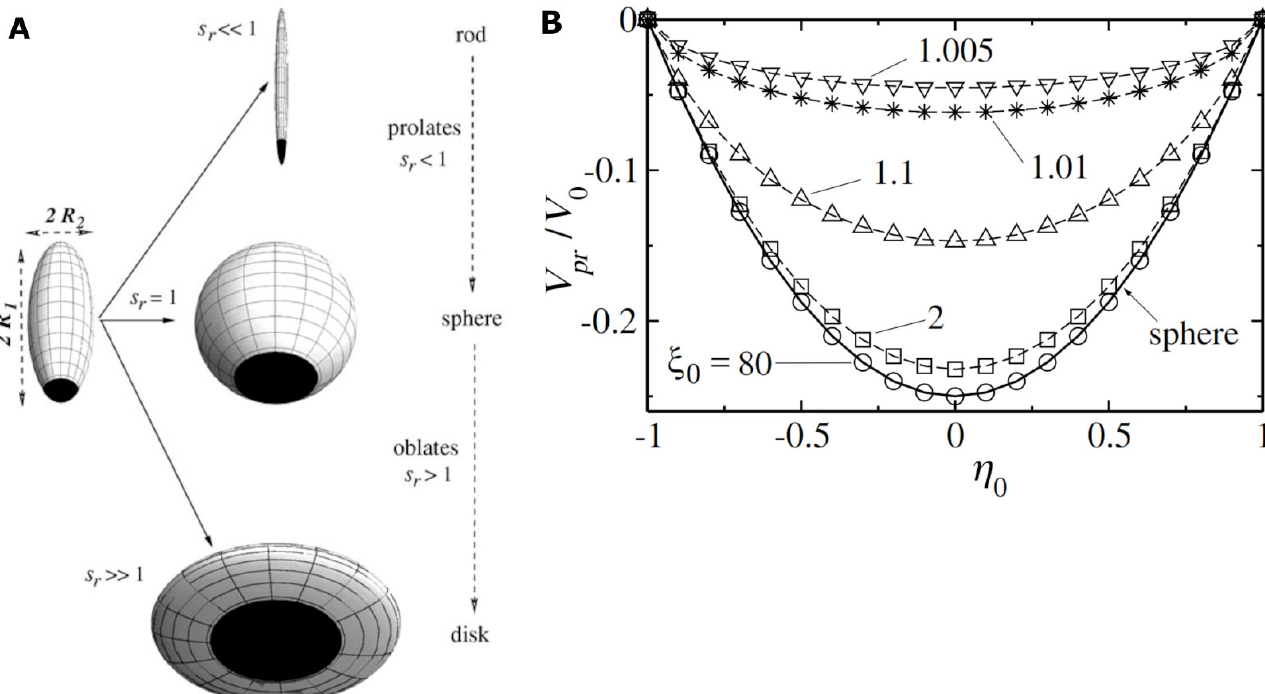
Figure 3. ( A ) Schematic representation of spheroidal catalytic micromotors characterized by the same polar semi-axis ( R 1 ), different equatorial semi-axes ( R 2 ), and, thus, different aspect ratios s r = R 2 / R 1 . (Obs.: The part of the catalytic micromotor covered by catalyst, that is, the active cap of the catalytic micromotor, is depicted as a black area). ( B ) The dependence of the scaled phoretic velocity ( V pr / V 0 ) on the fraction of the surface of the catalytic micromotor covered by the catalyst ( η 0 = − 1, 0, 1, respectively, correspond to a micromotor surface with no catalyst, with the lower half covered by the catalyst, and completely covered by the catalyst, respectively), for a prolate-shaped spheroidal catalytic micromotor with aspect ratio parameter ξ 0 = (1 − s r 2 ) − 1/2 = 80 ( s r = 0.9999), 2 ( s r = 0.866), 1.1 ( s r = 0.42), 1.01 ( s r = 0.14), and 1.005 ( s r = 0.099). The large ξ 0 values correspond to a quasi- spherical shape, while the limit towards 1 corresponds to needle-like shapes (approximating a long rod). Figures reproduced with permission from Ref.